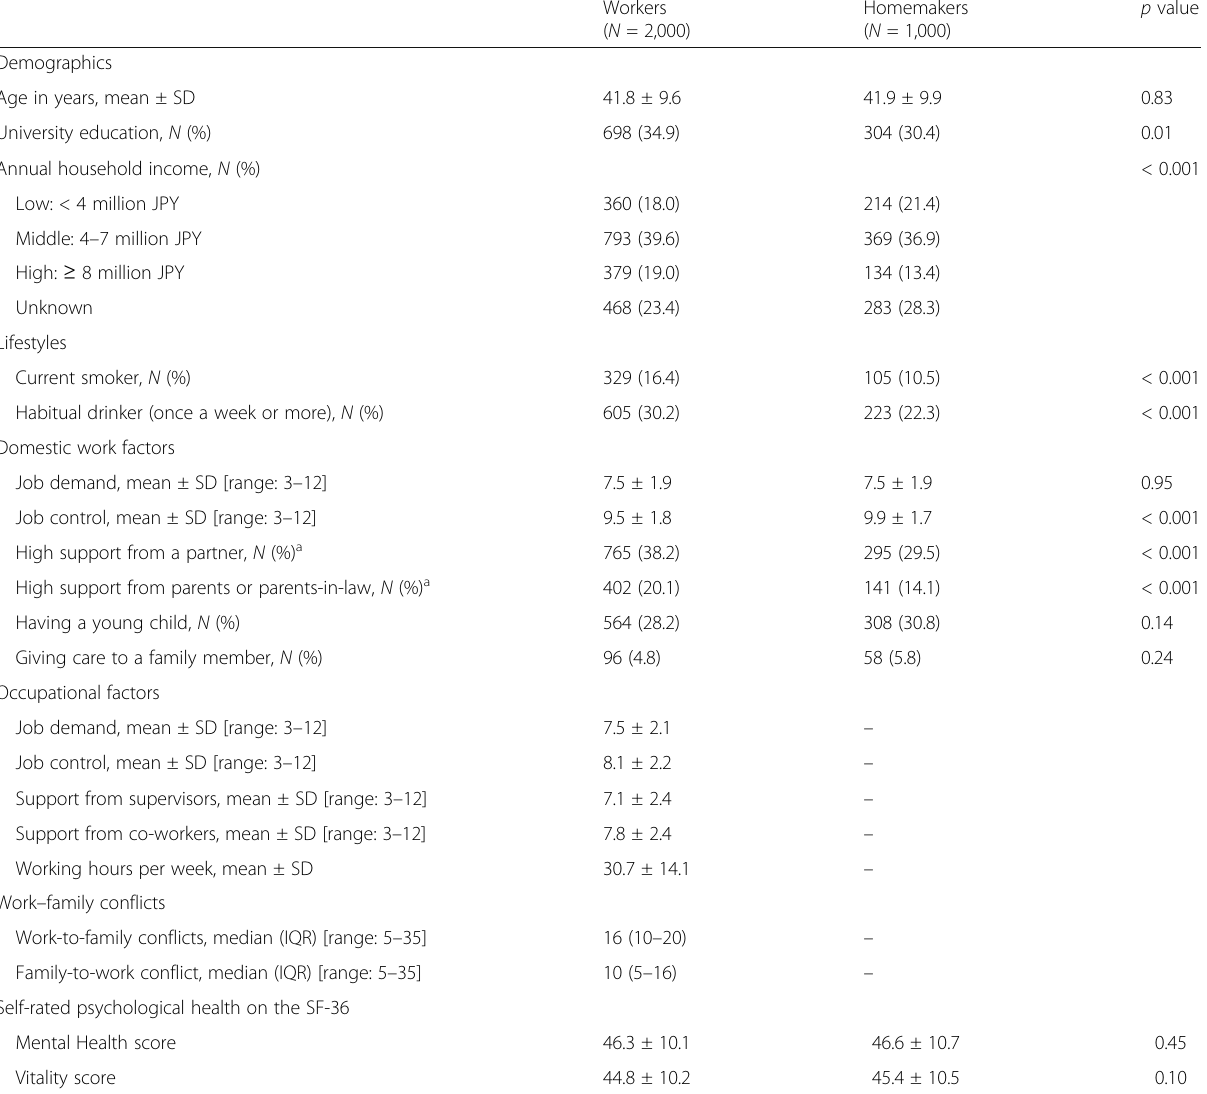
Table 1 Characteristics and self-rated psychological health of the study